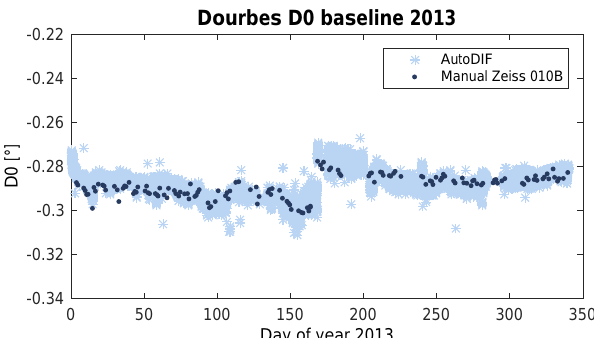
Figure 1. Baseline example computed from conventional manual measurements (dark blue) and the automatic system (light blue). In mid-2013, a baseline jump corresponding to an instrumental effect occurred, proving that regular absolute measurement are